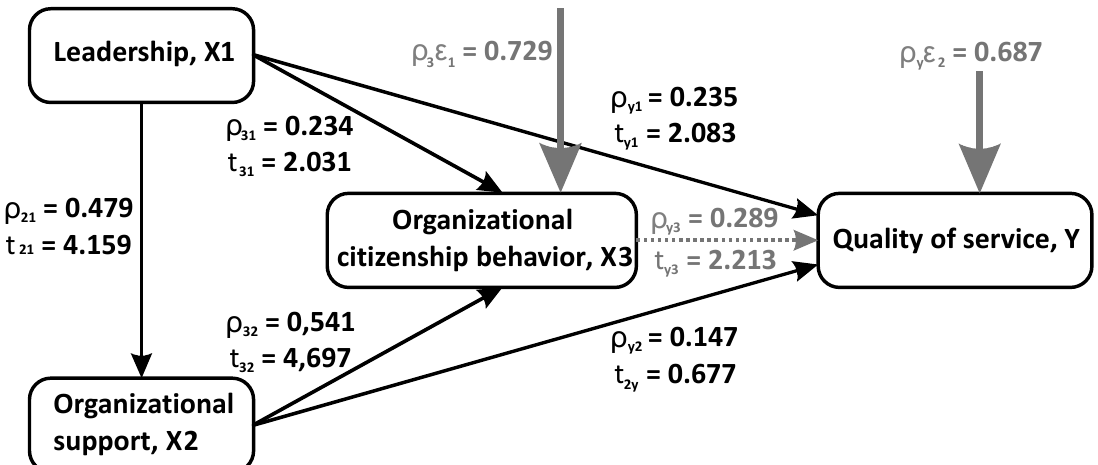
Figure 1. The summary of path coefficient test results in research structure